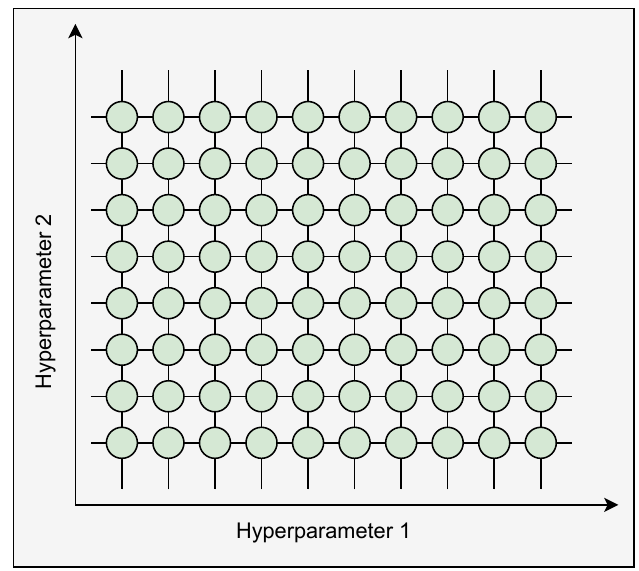
Figure 7. Grid Search sample plotting for two hyperparameters.